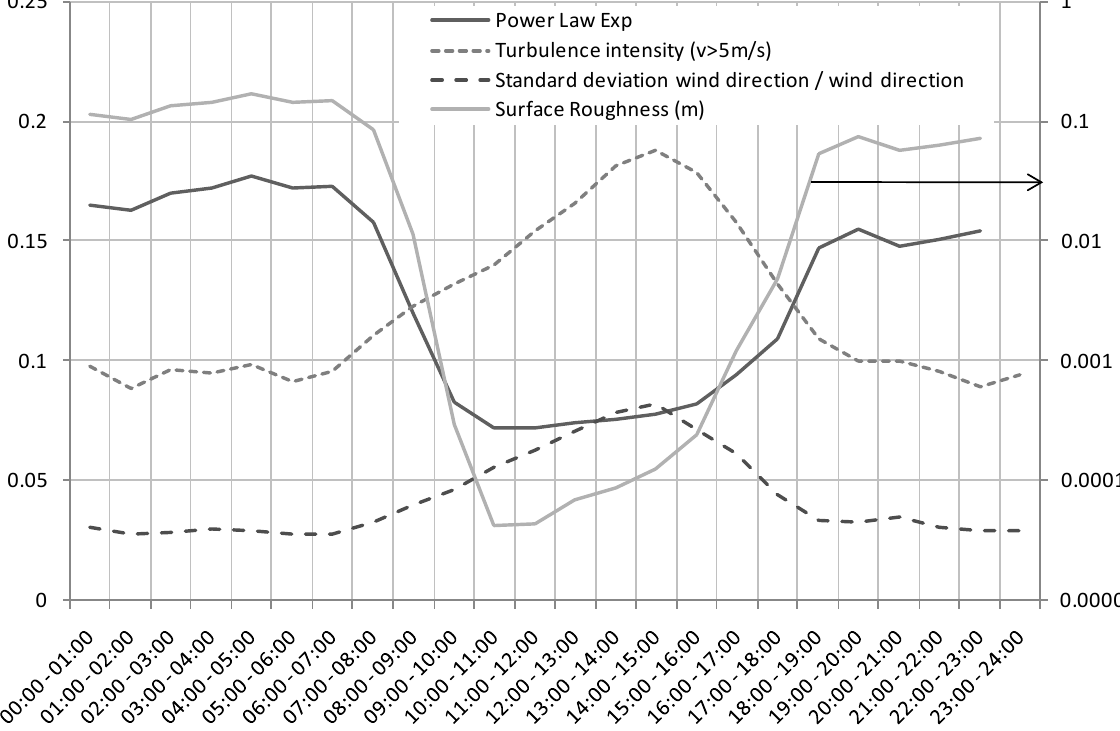
Figure 12. Daily variation of apparent surface roughness for a six-month measurement period compared to the corresponding variation in relative turbulence intensity and fluctuations in wind